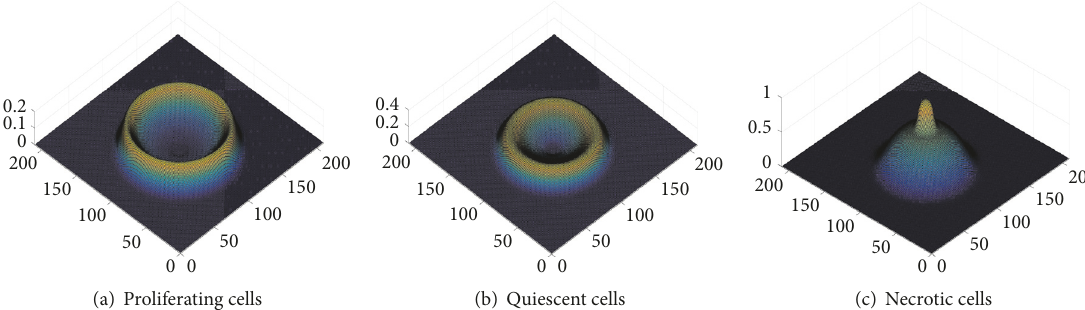
Figure 7: Typical profile of proliferating cells, quiescent cells, and necrotic cells without Allee effect at 𝑡 = 20 .